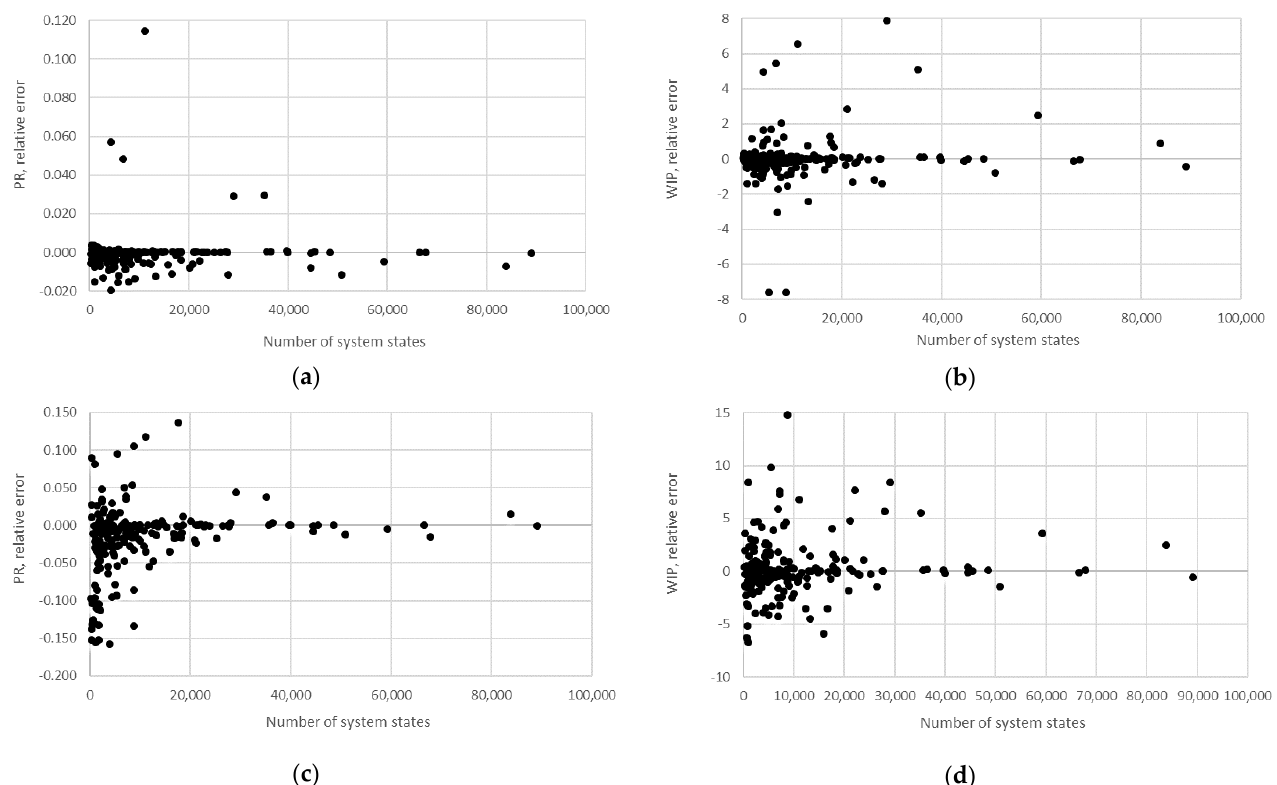
Figure 14. M = 5, relative error obtained using the ( a , b ) AGG procedure and ( c , d ) FSM.